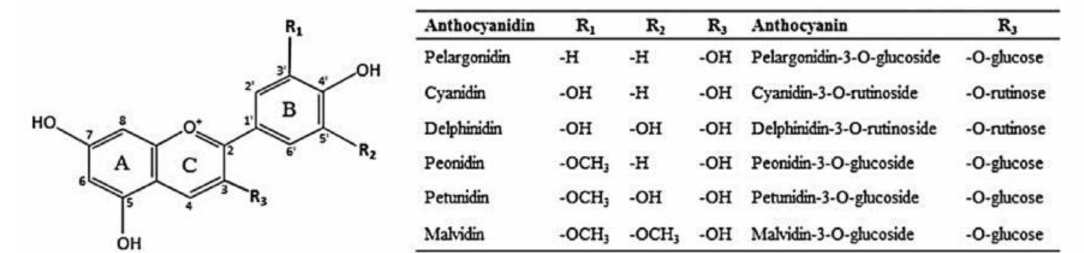
Figure 1. Structure of anthocyanidins commonly found in berry fruits and examples of corresponding anthocyanins with R 3 glycosides. Reproduced with permission from